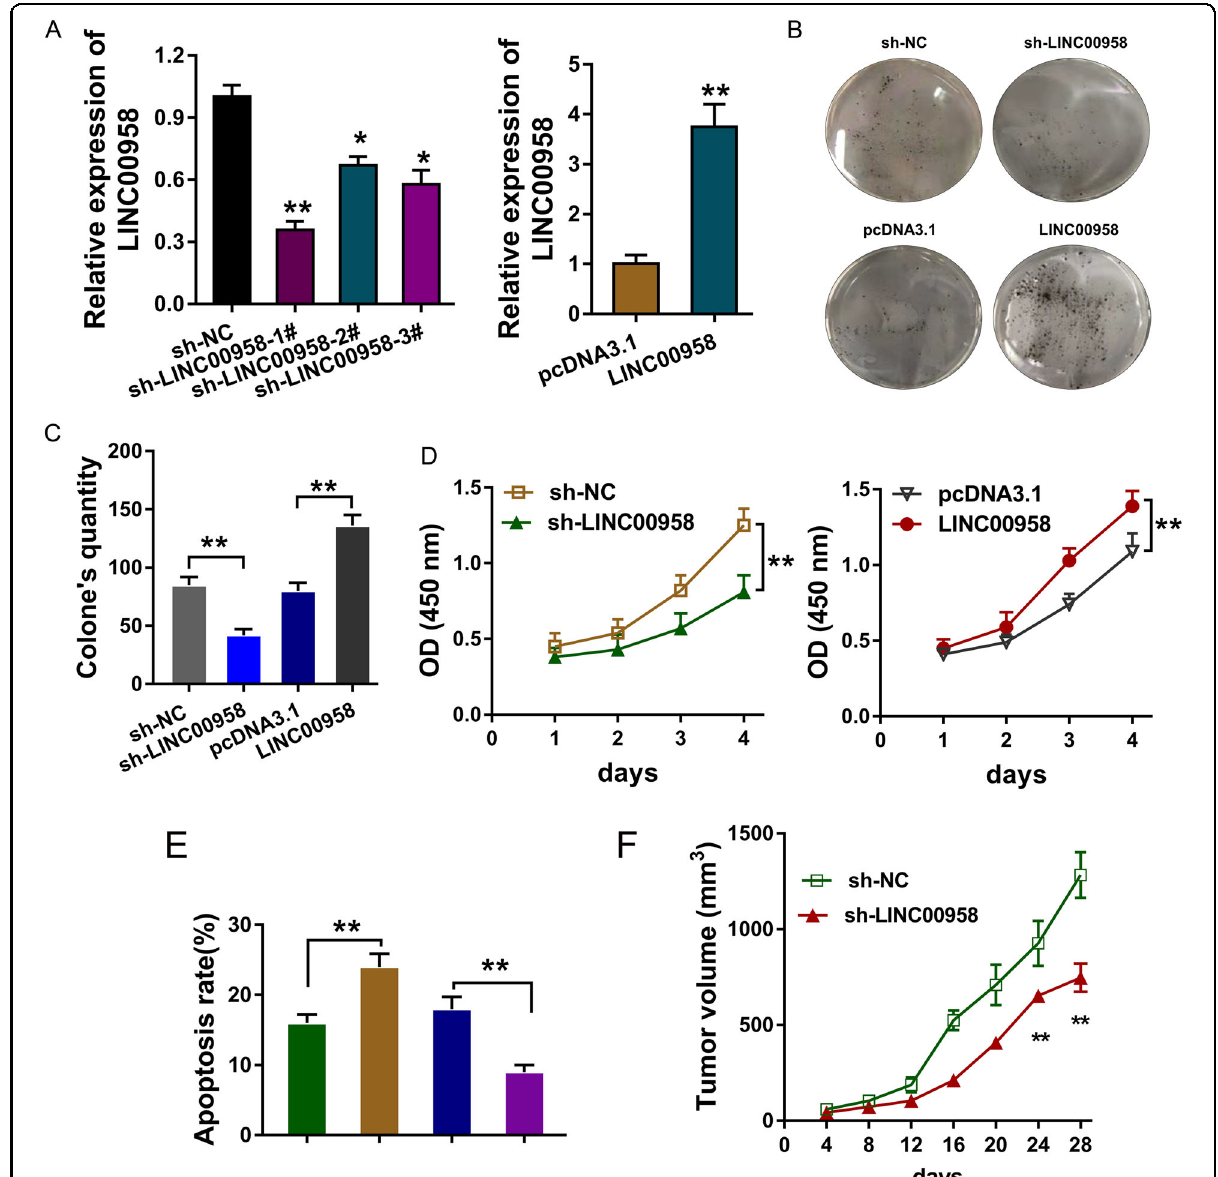
Fig. 3 LINC00958 promoted the tumor progression of BC cells. A Gain- or loss-of-function assays were performed in MCF-7 cells transfected with sh-LINC00958 or LINC00958 overexpression vector. B , C Colony formation assay and D CCK-8 assays illustrated the proliferation of MCF-7 cells transfected with sh-LINC00958 or LINC00958 overexpression, as well as control groups. E Flow cytometry analysis of apoptosis demonstrated the apoptosis of MCF-7 cells transfected with sh-LINC00958 or LINC00958 overexpression. F In vivo mouse assays showed the inhibition of tumor growth by sh-LINC00958 transfection. ** p < 0.01 and * p < 0.05 were considered signi fi